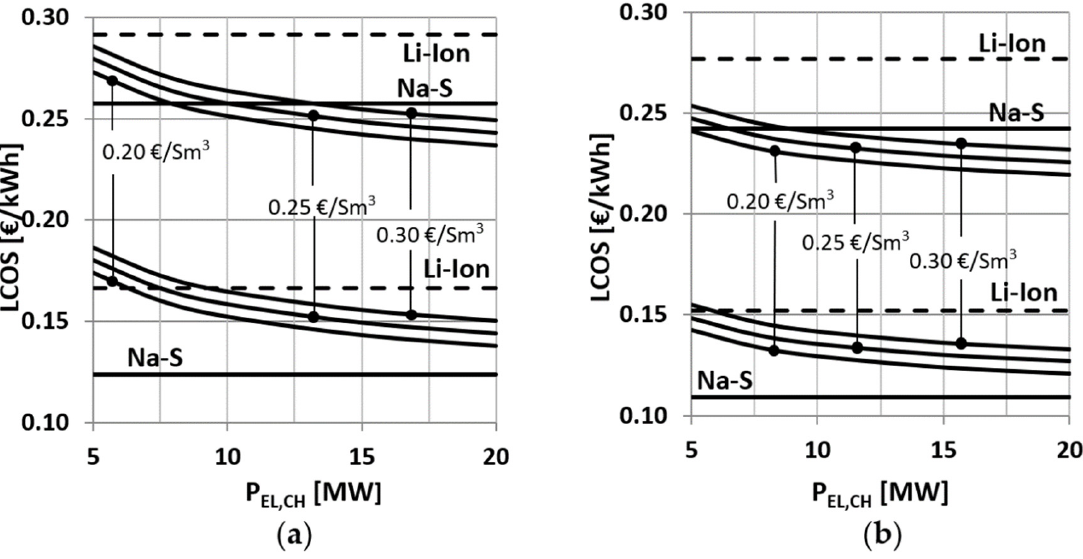
Figure 4. LCOS by varying the rated charging power of storage systems under comparison: ( a ) Case t CH = t DS = 6 h; ( b ) Case t CH = t DS = 10 h.